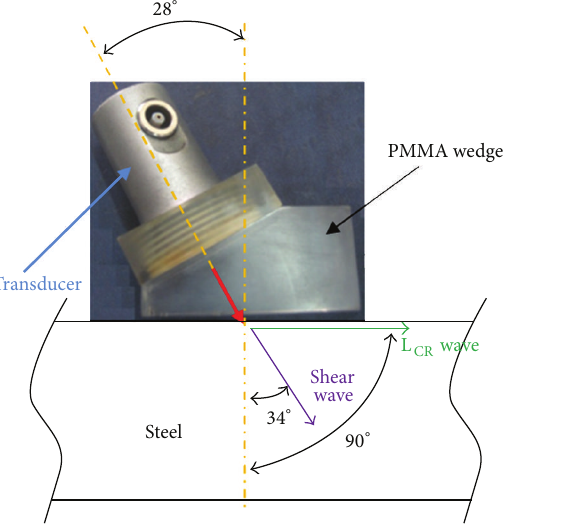
Figure 1: L CR probe for PMMA (Plexiglas) wedge on steel.